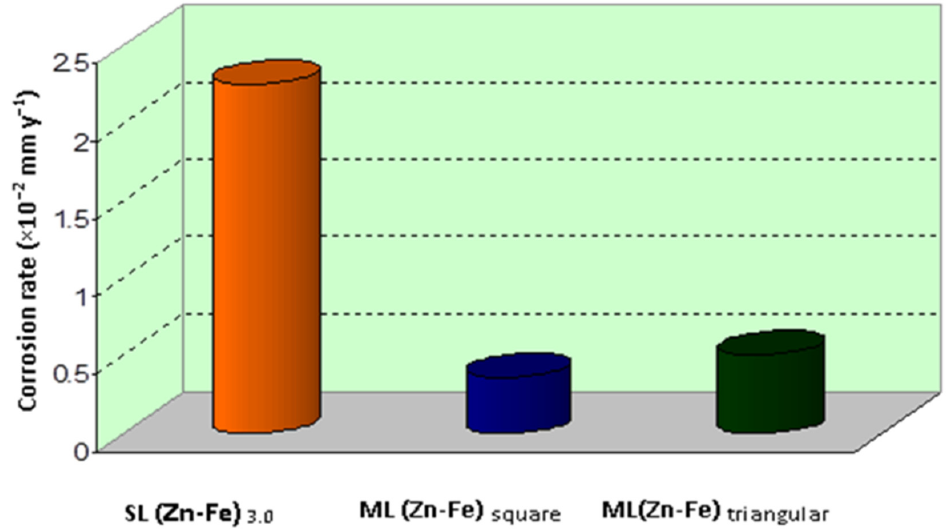
Figure 4. Relative analysis of corrosion rate of single-layer and ML alloy fi lms.